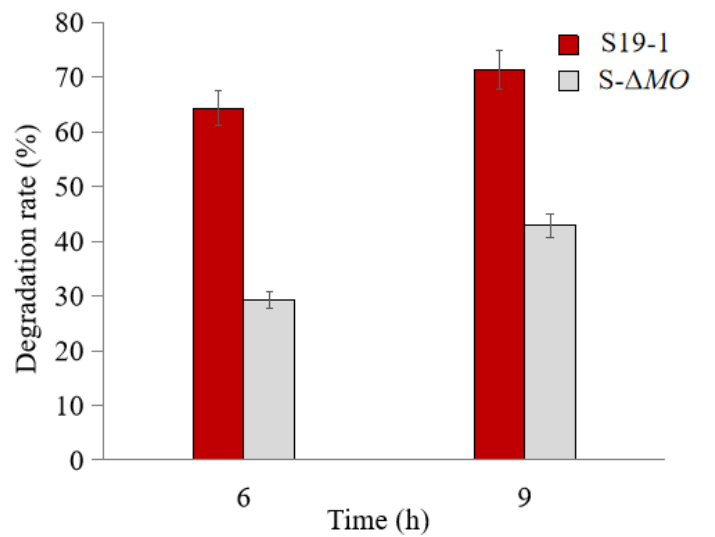
Figure 4. TNT degradation by wild type S19-1 (red) and the S- ∆ MO (gray) mutant. TNT degradation was assessed after 6 h or 9 h, respectively. Data are presented as mean of N = 4, x ± SD. Statistical significance is denoted as p < 0.05 using SPSS.